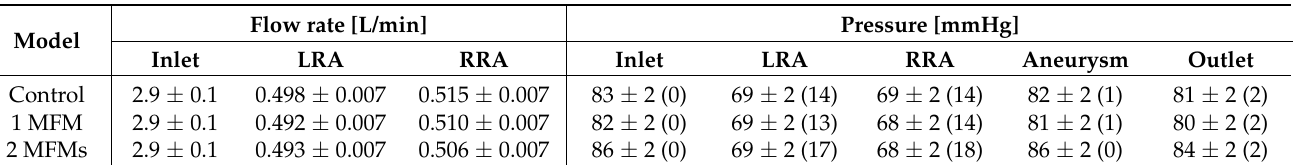
Table 2. Flow rate and pressure values measured during PIV experiments. Values are reported as mean ± standard deviation. Pressure drop compared to inlet pressure is indicated under